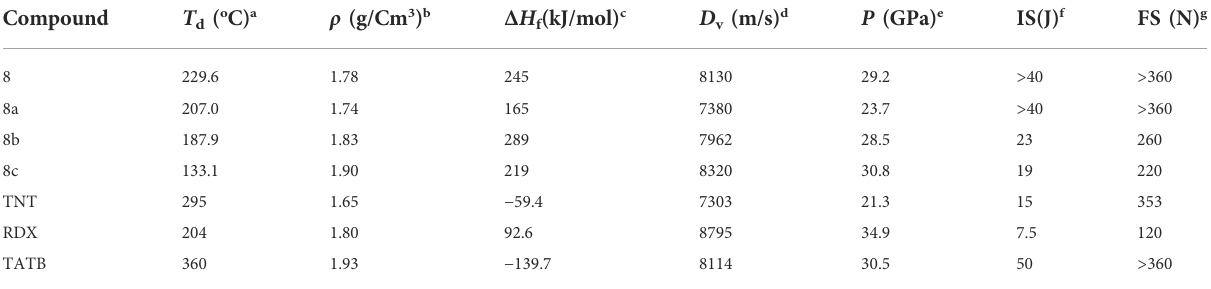
TABLE 3 Properties of compounds 8 -